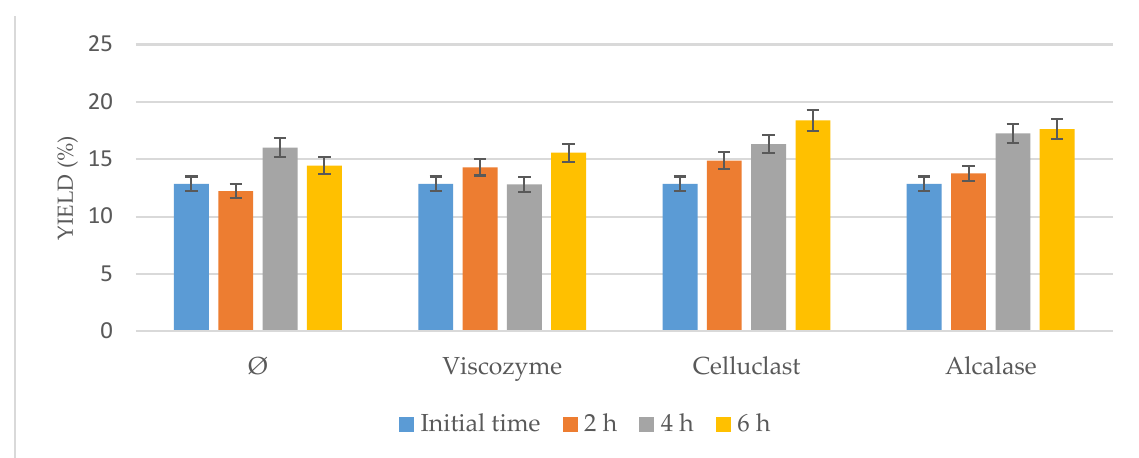
Figure 2. Ultrasound-assisted enzymatic pretreatment at 55 °C, pH 5.0 and different times (2, 4, and 6 h) compared to not pretreated biomass (Ø ) under the same conditions.